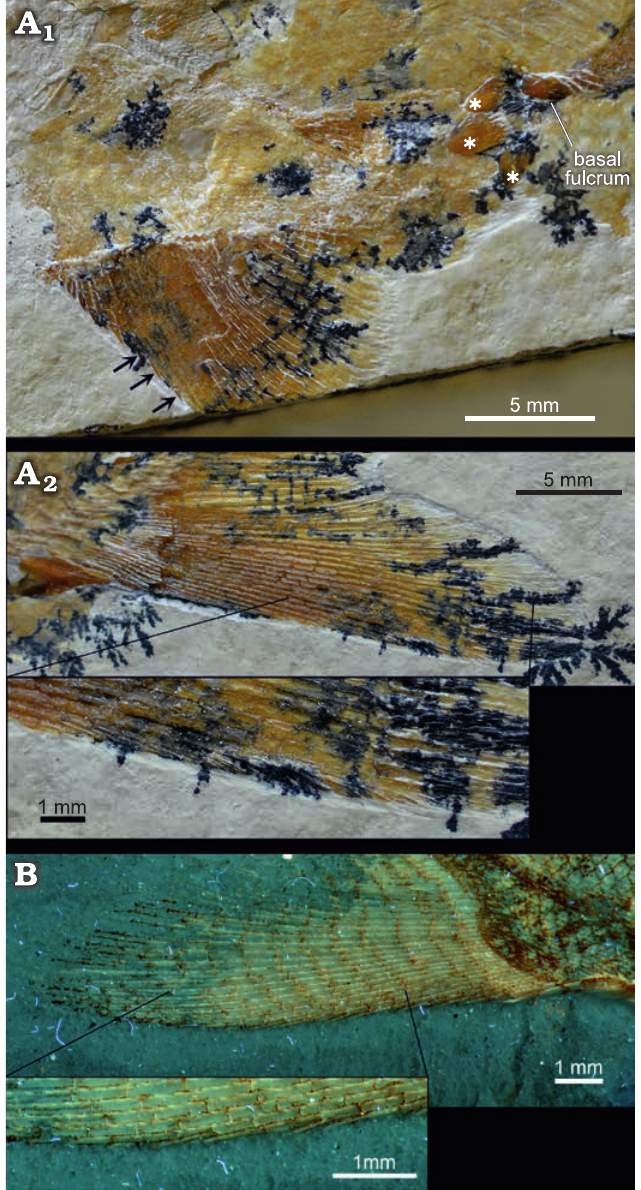
Fig. 4. Fringing fulcra in the chondrostean fishes Coccolepis bucklandi Agassiz, 1843 (A), and Coccolepis solnhofensis sp. nov. (B) from the Titho nian, Upper Jurassic of the Solnhofen Lagerstätte, Bavaria, Germany. A . JME-SOS3445, pelvic fins and preanal scutes (A 1 ). Arrows point to the preserved fringing fulcra; asterisks signal the three preanal scutes. Detail of the ventral margin of the caudal fin (A 2 ). B . SNSB-BSPG AS I 1328, detail of the ventral margin of the caudal fin. Photograph taken under UV-light, courtesy of Helmut Tischlinger (Stammham,